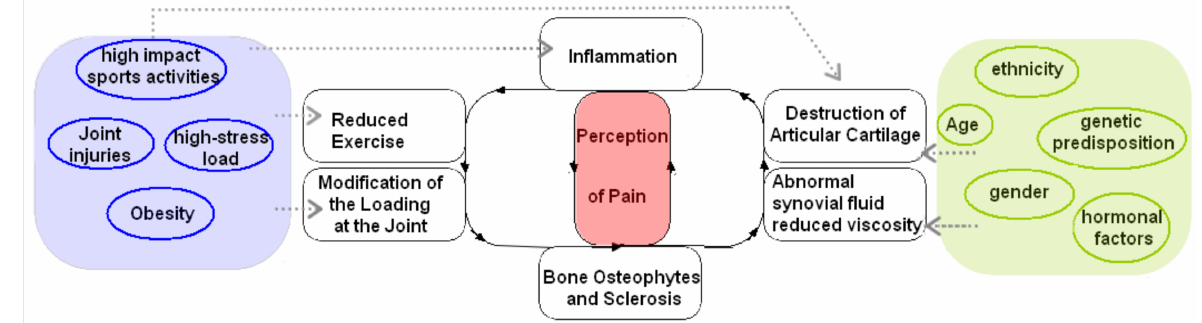
Figure 1. The vicious circle of OA progression and risk factors are associated where pain perception is central to the